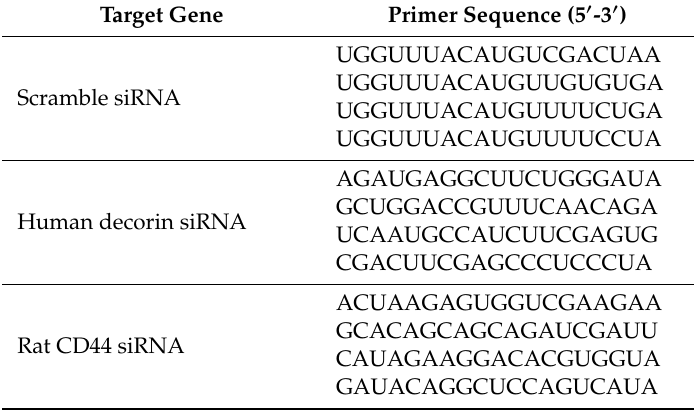
Table 1. Sequences of primers used for indicated target genes. Target